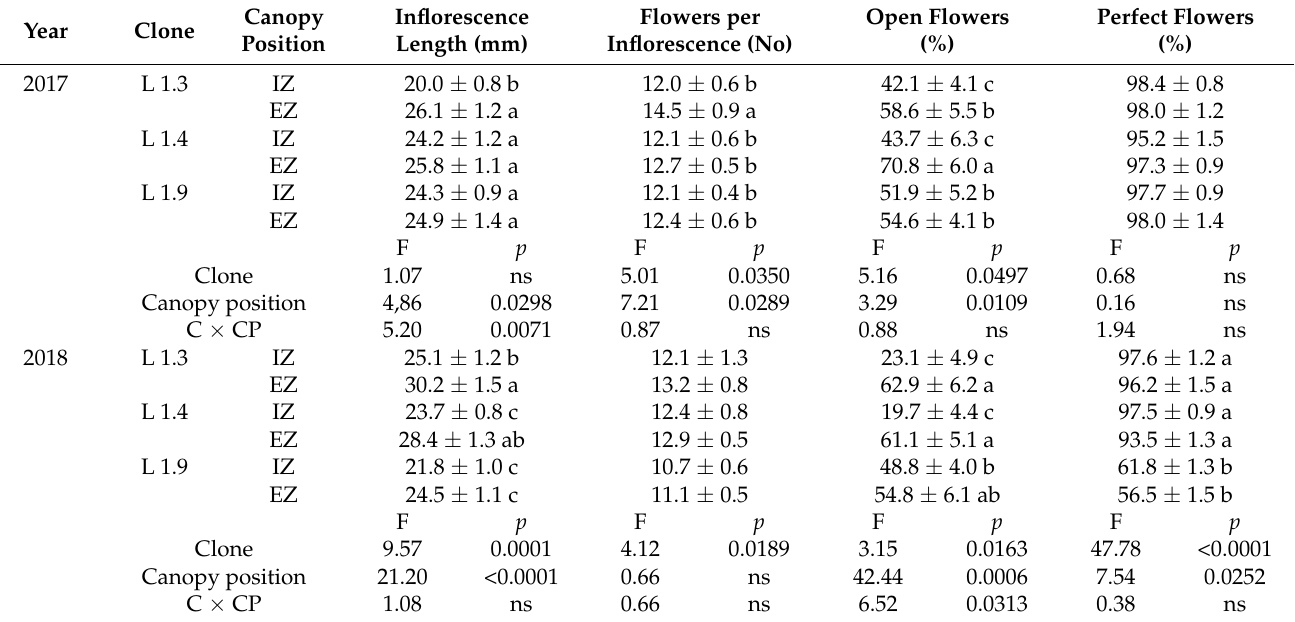
Table 1. Characteristics of inflorescences (length and flowers per inflorescence) and flowers (open and perfect flowers) of samples collected from IZ and EZ of the canopy for three Leccino clones (L 1.3, L 1.4, L 1.9). For each spring season (2017–2018), values are means ± standard error. Different letters indicate differences at p ≤ 0.05 (Tukey test) among the Clone-Canopy Position combinations within each year. Letters are only presented when ANOVA indicate significant effect. Two-way ANOVA results; main effect: clone (C), canopy position (CP). F- and p -values are shown; ns: not significant. Perfect